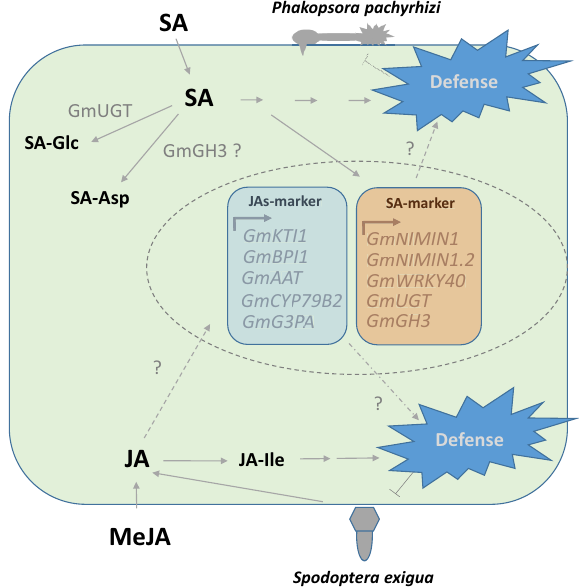
Figure 5. Molecular responses of soybean leaves to SA, MeJA, P. pachyrhizi attack, or S. exigua feeding. Treatment with SA or inoculation with P. pachyrhizi spores induces the consecutive accumulation of free and glycosylated SA and expression of SA-responsive genes with a suspected role in either the defense of biotrohic pathogens or SA homeostasis. JA and JA-Ile accumulate after MeJA exposure. They trigger the expression of JA-responsive genes with a presumed function in insect defense. SA salicylic acid, SA-Asp salicyloyl-aspartate, SA-Glc salicylic acid glucoside (SAG) or salicylic acid glucose ester (SGE), JA jasmonic acid, MeJA methyl jasmonate, JA-Ile jasmonic acid